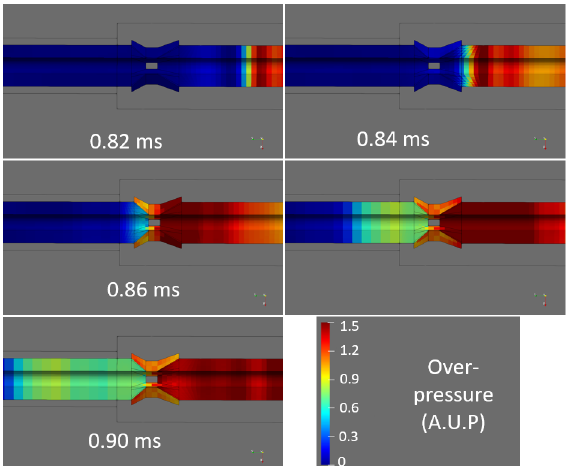
Figure 6. Representation of the fluid pressure field around the outlet transition at different time steps when the main pressure wavefront crosses the transition. For the sake of clarity, the structure is not shown.